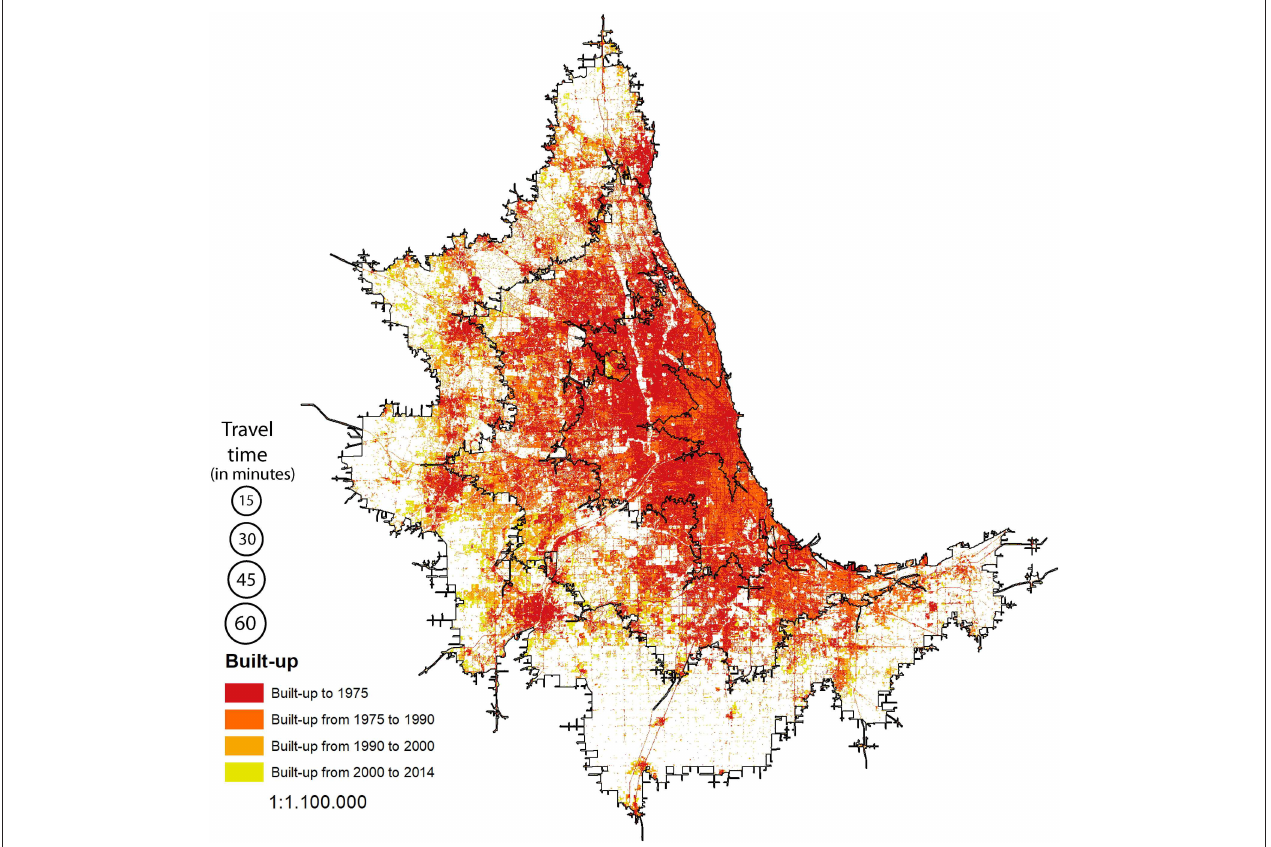
FIGURE 6 | Urbanization periods in Chicago, based on the